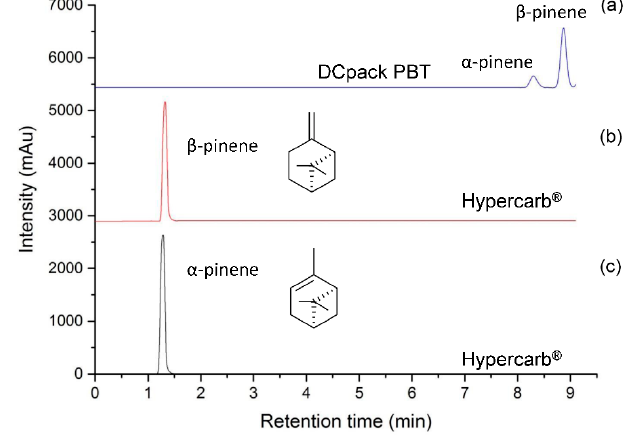
Figure 1. Comparison of α -pinene and β -pinene separation using CO 2 (A) and methanol (B) mobile phase, flow rate of 1.5 mL/min, gradient mode: 0.0–3.0 min (0% B), 3.0–16.0 min (0–10% B), 16.0–17.0 min (10–0% B) and 17.0–19.0 min (0% B): ( a ) Two columns in series a Hypercarb ® (150 mm × 4.6 mm, 5 µ m) and a Poly-(butylene terephthalate) DCpack PBT(150 mm × 4.6 mm, 5 µ m), DAICEL Corporation (Osaka, Japan). ( b , c ) standards of α -pinene and β -pinene only using a Hypercarb ® (150 mm × 4.6 mm, 5 µ m).